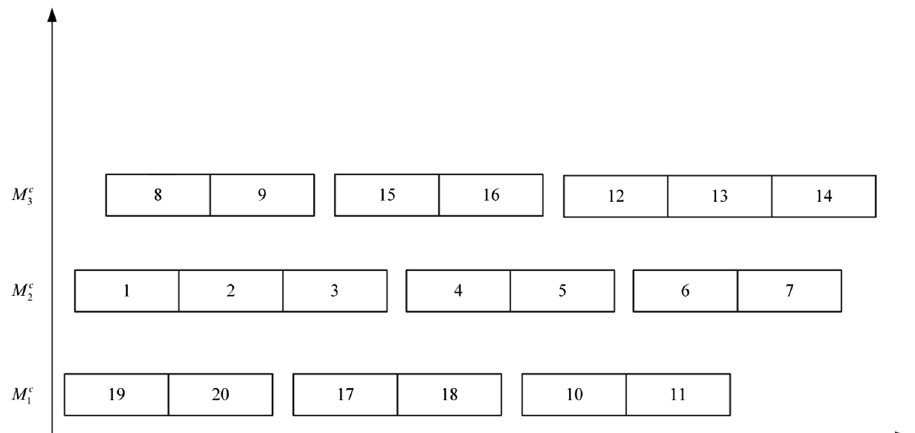
Fig. 6 The jobs processing sequence in stage